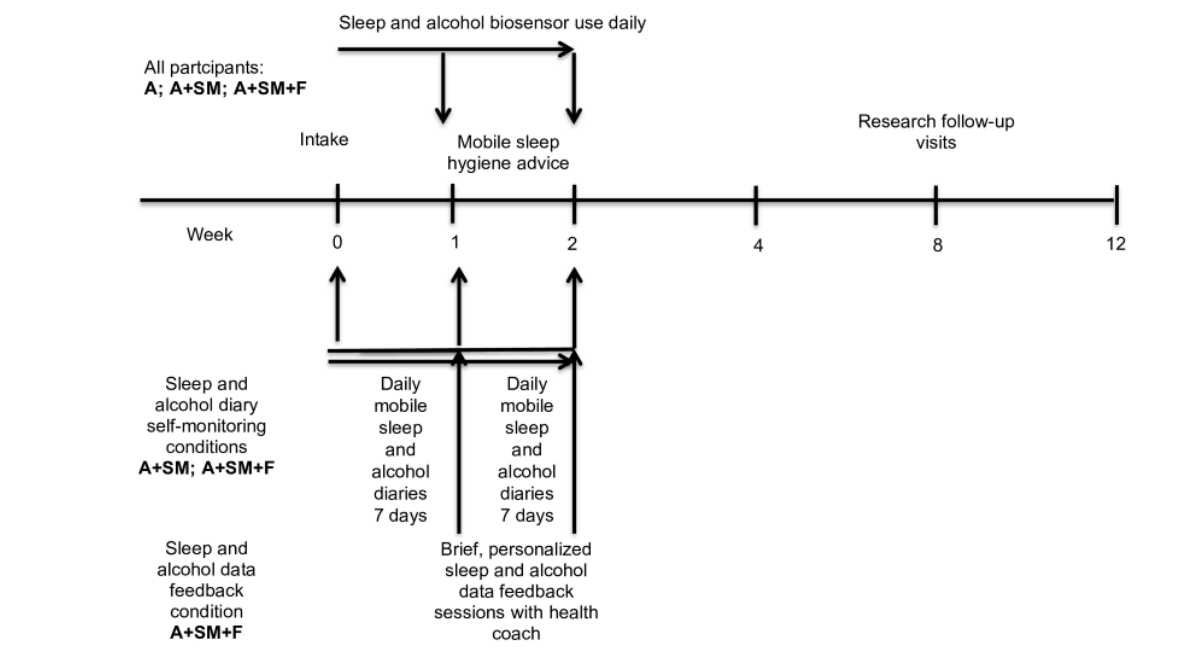
Figure 1. Single participant